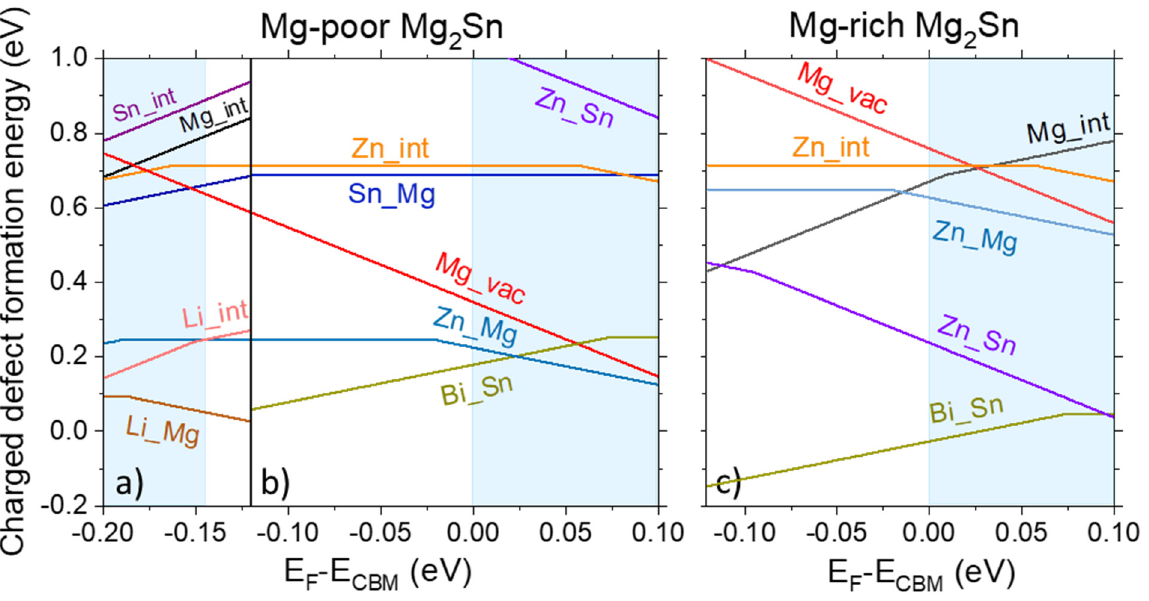
Figure 5. Charged defect formation energies for Zn defects in: ( a ) Li-doped ( b ) Bi-doped Mg 2 Sn under Mg-poor conditions ( c ) Bi-doped Mg 2 Sn under Mg-rich conditions. For simplicity, the results relevant for the Li-doped samples are represented in the Fermi level region around VBM only.